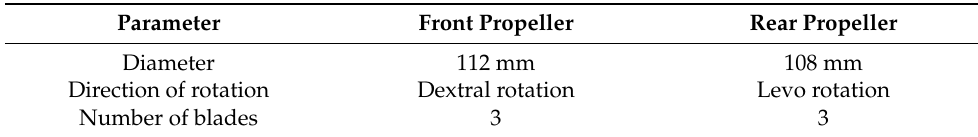
Table 2. The main parameters of the CRP. Figure 20. Propeller test and simulation results ( a ) and the error assessment of the simulation results ( b ).